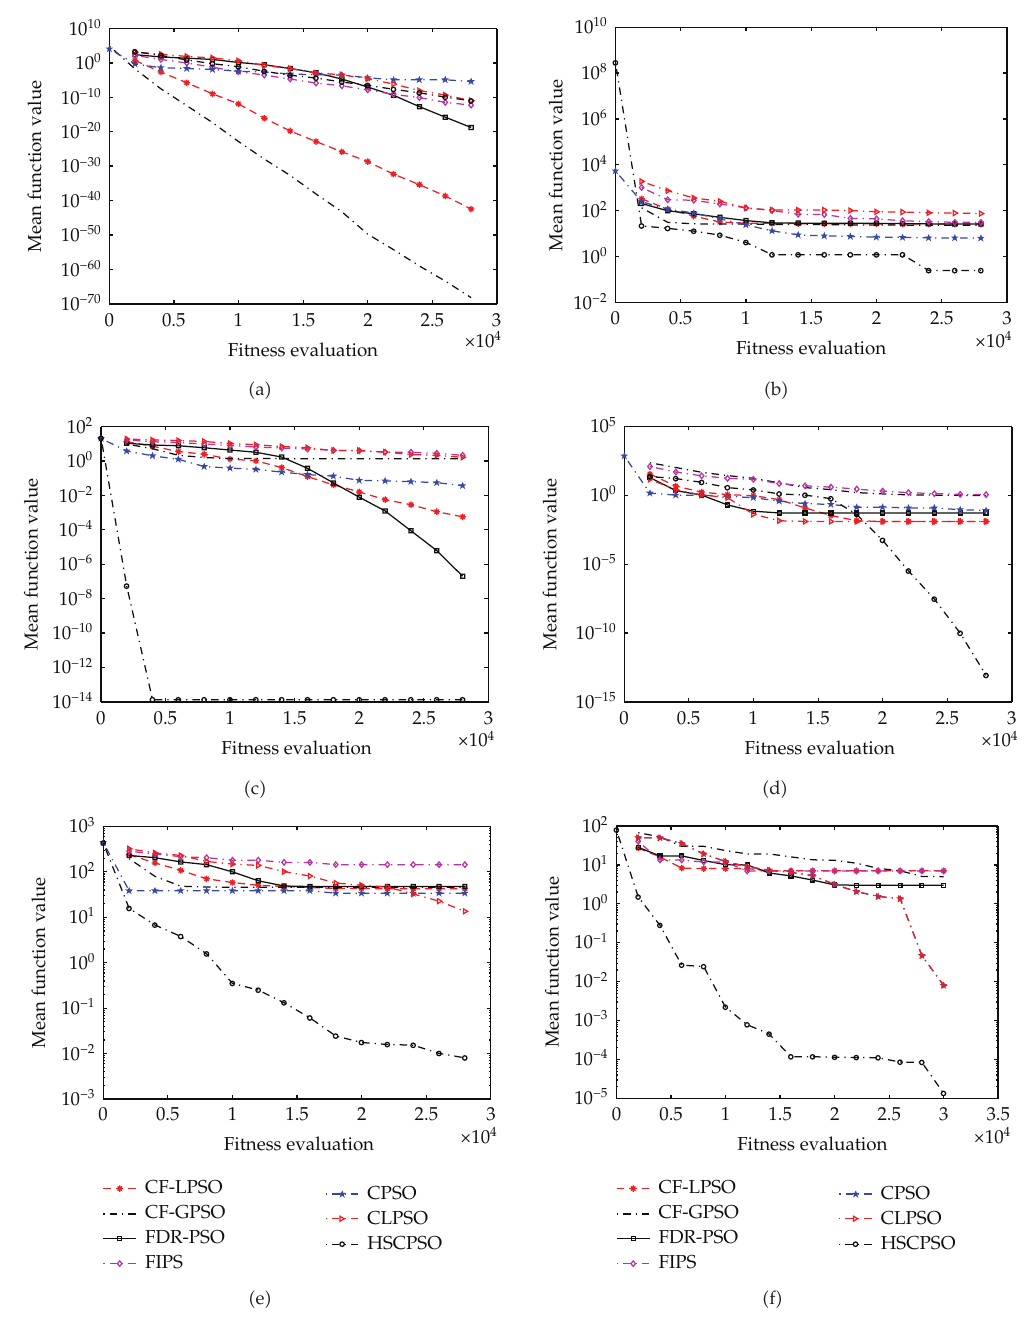
Figure 9: Convergence characteristics of the unrotated test functions. (cid:2) a (cid:3) Sphere; (cid:2) b (cid:3) Rosenbrock; (cid:2) c (cid:3) Ackley; (cid:2) d (cid:3) Griekwanks; (cid:2) e (cid:3) Rastrigin; (cid:2) f (cid:3)